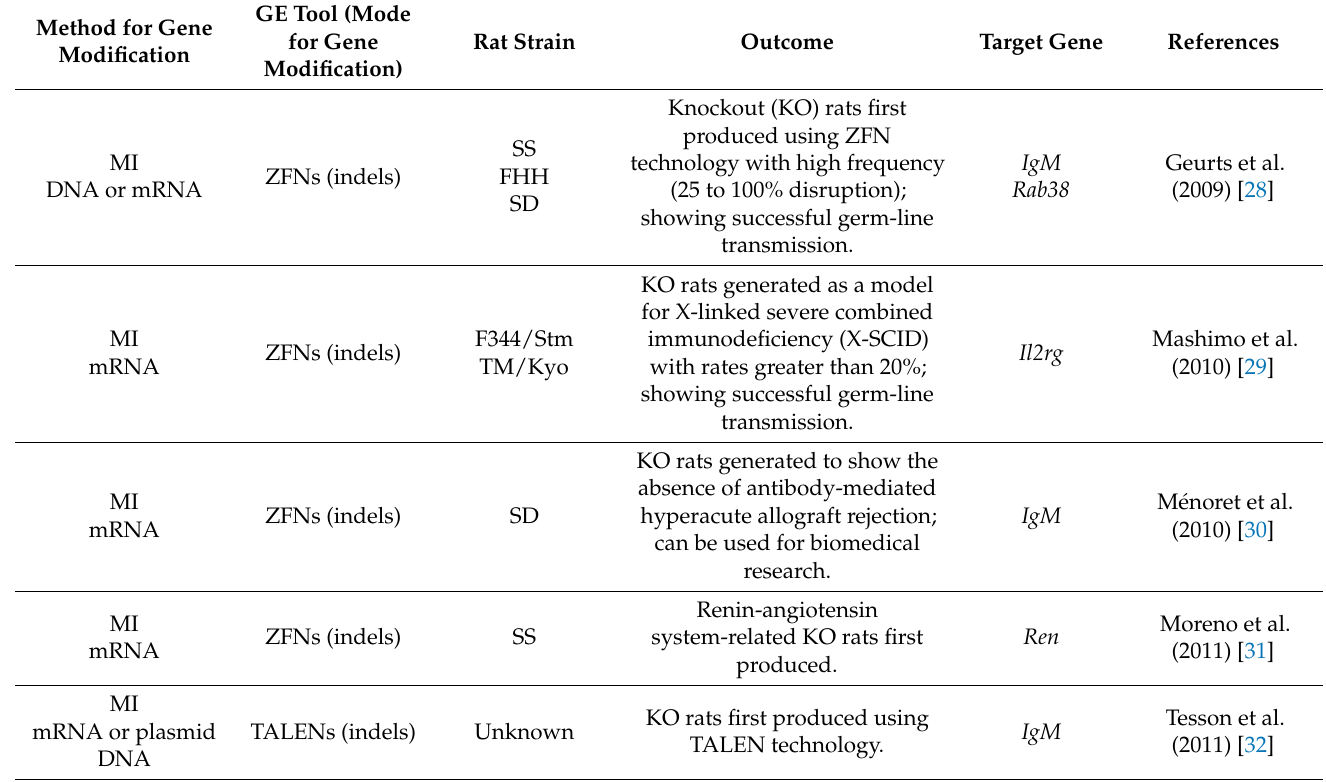
Table 1. Summary of the production of genome-edited (GE) rats from 2009 to